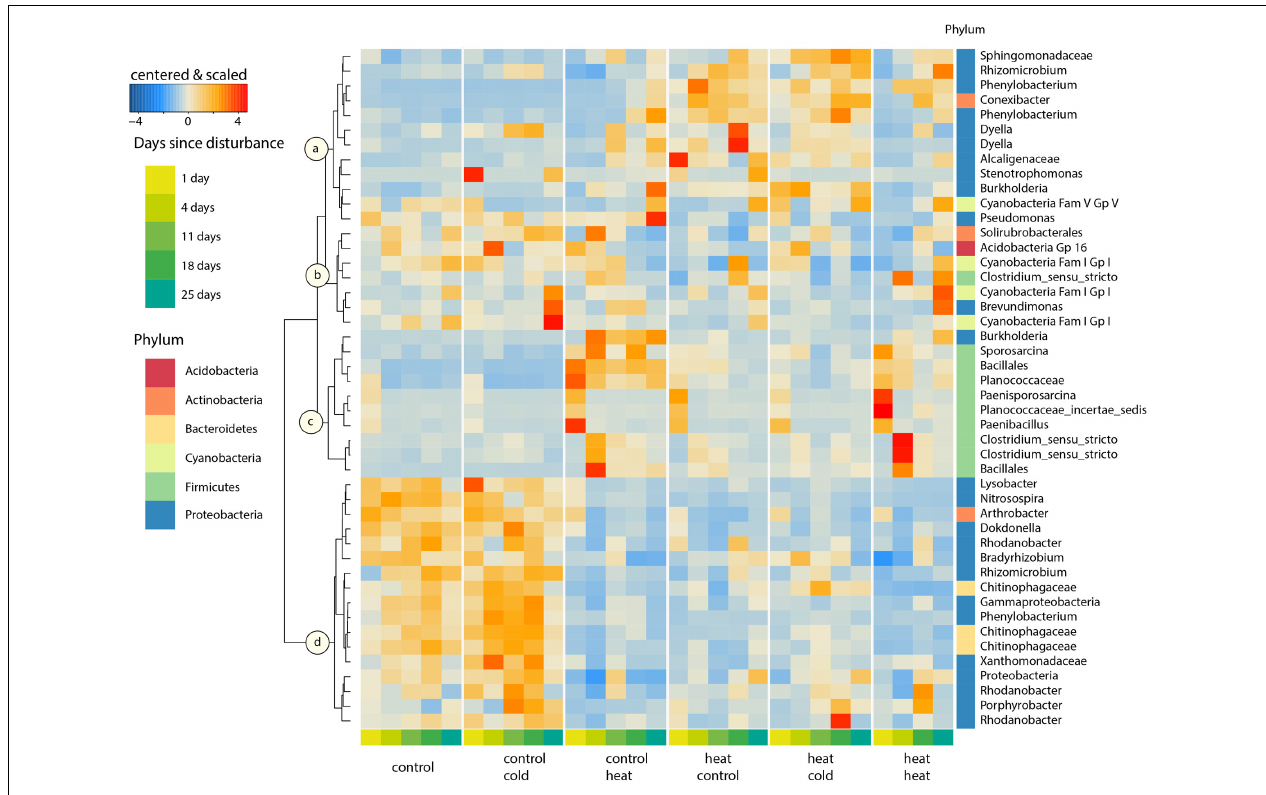
FIGURE 5 | Core dynamic taxa. Heatmap of the Bray–Curtis distances of 46 OTUs, which explain 50% of the separation between treatments and between successional stages within each treatment. OTUs were selected according to pairwise SIMPER analyses and clustered using Ward’s method. These taxa represent 41.6% of the total community. Abundances were averaged per time point, and centered and scaled prior to plotting. The phylum membership of each OTU is displayed in the right column. OTUs at the lowest taxonomic classification level are listed on the right. Taxa were clustered into four groups (a–d) according to their temporal response patterns. A list of the samples lost during extraction and processing is included in Supplementary Table